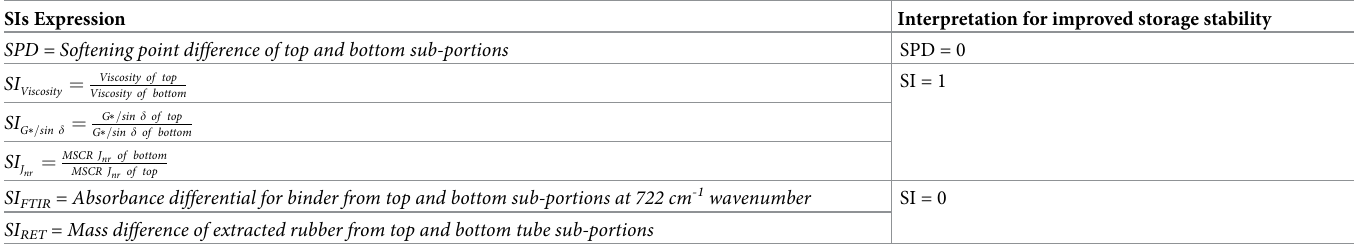
Table 3. Specifics of separation indices